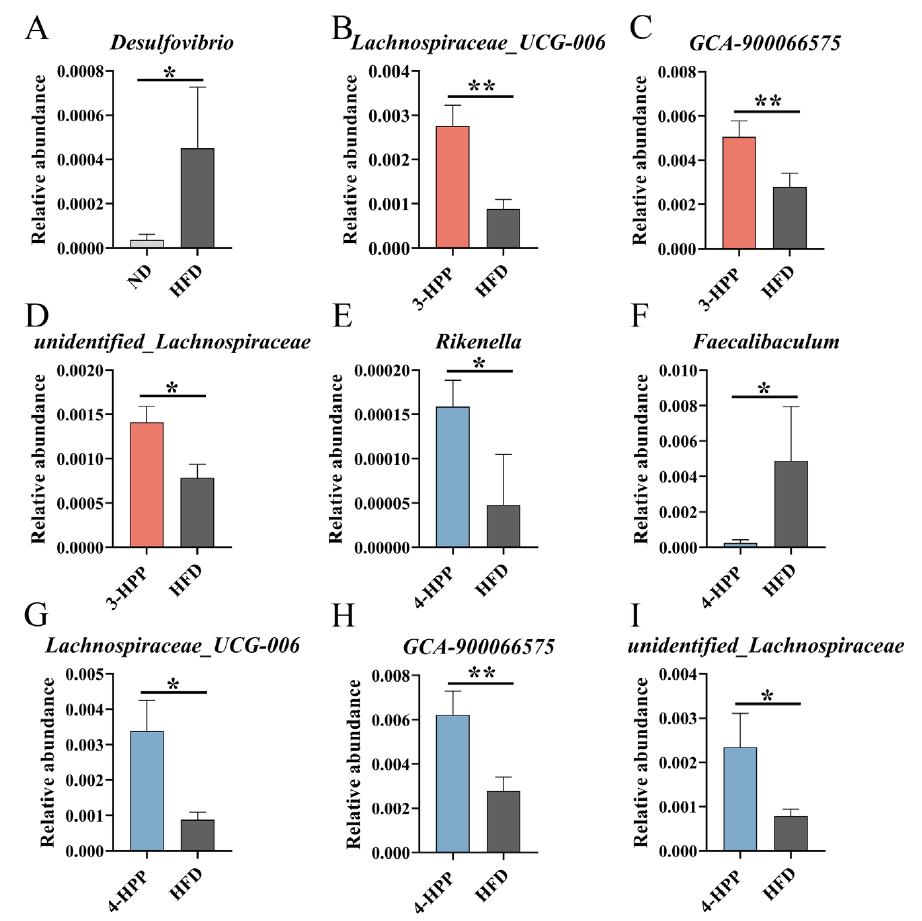
Figure 6. The effects of 3 − HPP and 4 − HPP on the relative abundance of key genera in different groups. Relative abundance of Desulfovibrio ( A ) between the ND and HFD groups. Relative abundance of Lachnospiraceae_UCG-006 ( B ), GCA-900066575 ( C ), and unidentified_Lachnospiraceae ( D ) between the 3 − HPP and HFD groups. Relative abundance of Rikenella ( E ), Faecalibaculum ( F ), Lachnospiraceae_UCG-006 ( G ), GCA-900066575 ( H ), and unidentified_Lachnospiraceae ( I ) between the 4 − HPP and HFD groups. Data are expressed as means ± SDs. n = 5 if not specified. The results were analysed by a Wilcoxon rank sum test. * p < 0.05 and ** p < 0.01 compared to the HFD group.